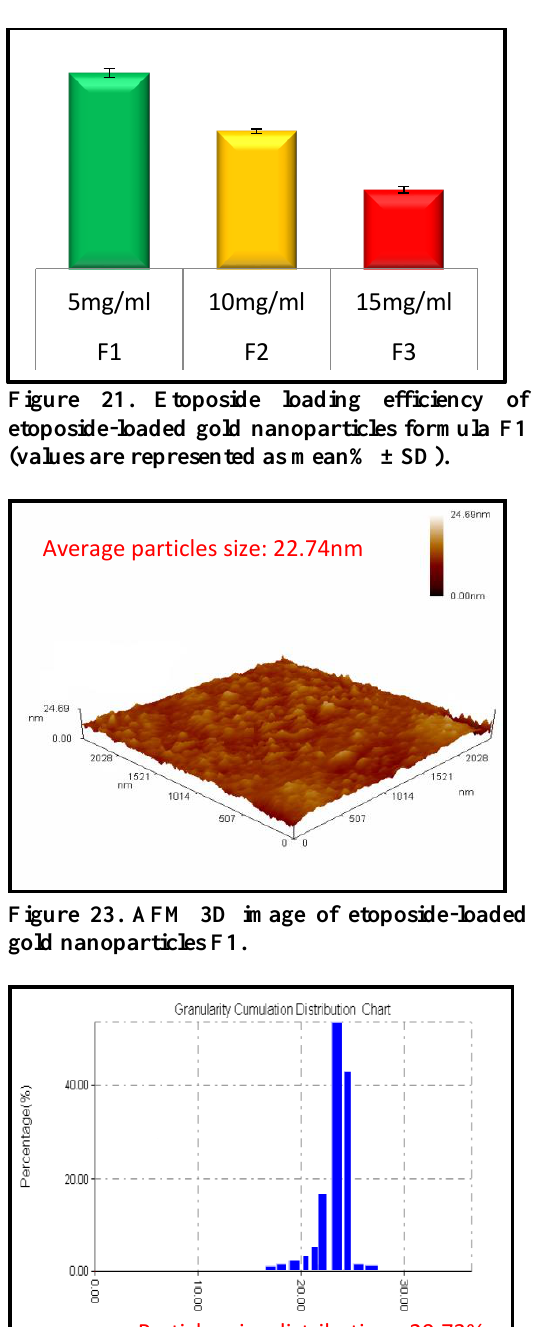
Particles size distribution: Figure 24. AFM size distribution of etoposide- loaded gold nanoparticles F1.